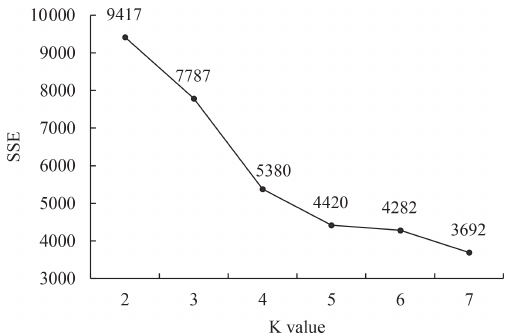
Figure 7. Sum of squared errors (SSE) corresponding to different clustering numbers ( K